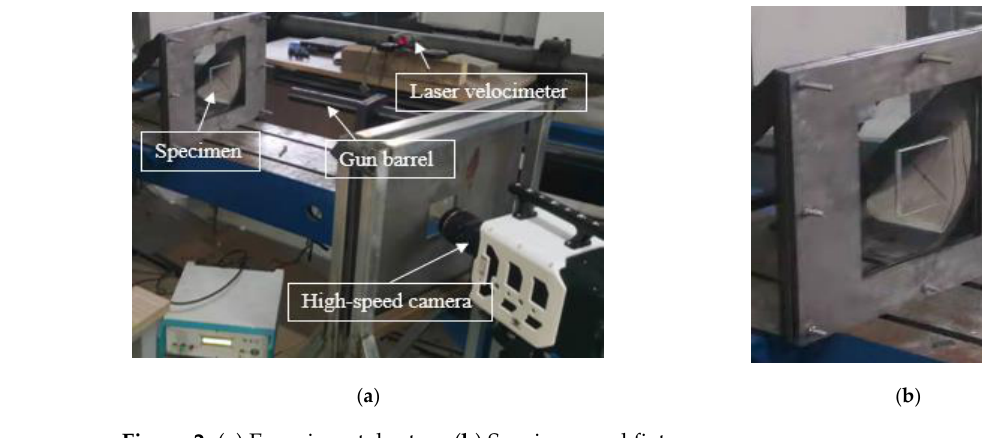
Figure 2. ( a ) Experimental setup; ( b ) Specimen and fixture.